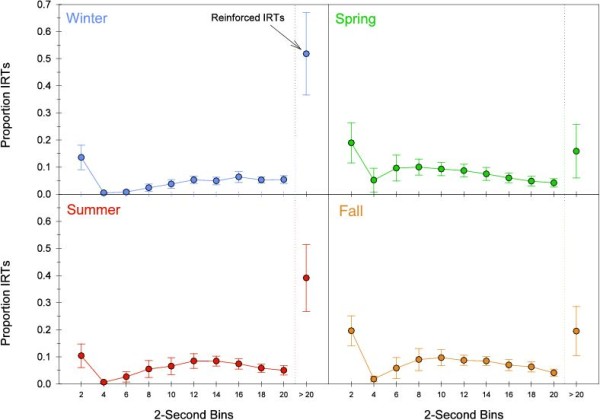
Relative frequency distribution of interresponse times (IRTs) using a bin size of 2 seconds averaged across birds in each season. Dashed line indicates the time at which IRTs were reinforced. Proportion of reinforced IRTs, those which occur after the 20 second delay, is shown to the right of the dashed line. IRT distributions are typically bimodal, with the most IRTs either short or long enough to be reinforced. N = 15. Error bars represent the 95% CI.